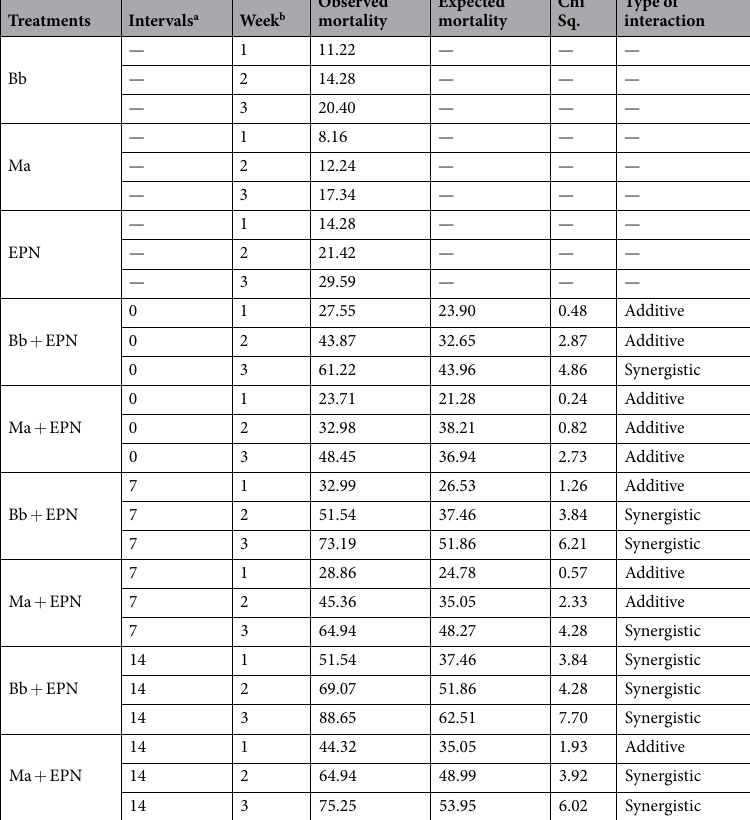
Table 1. Mean mortality (% ± SE) of 2 nd instar larvae of Rhynchophorus ferrugineus treated with